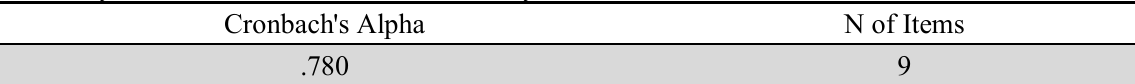
Reliability Statistics for firm innovation activity